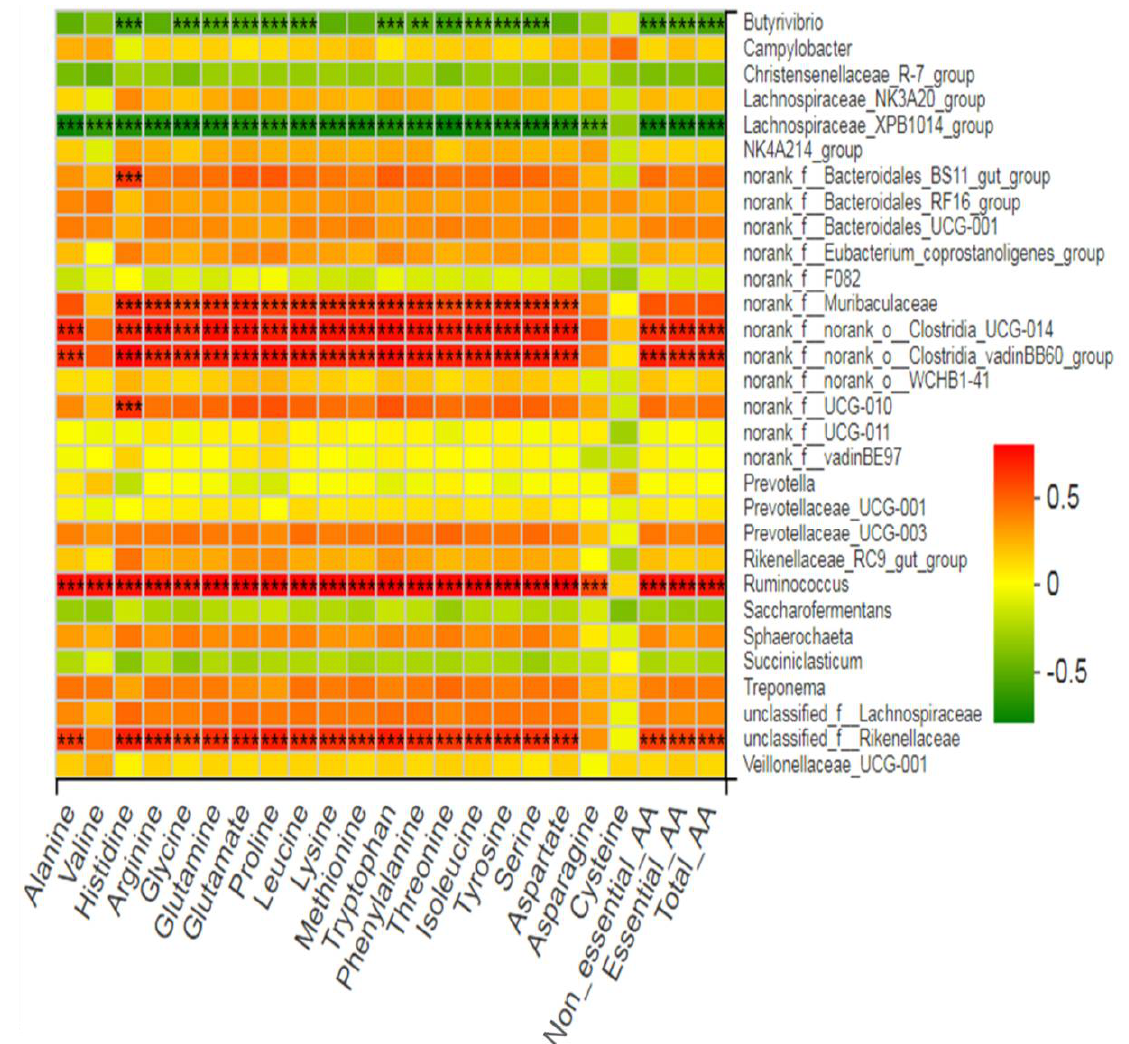
Figure 10. Correlation of bacterial genera with ruminal amino acid